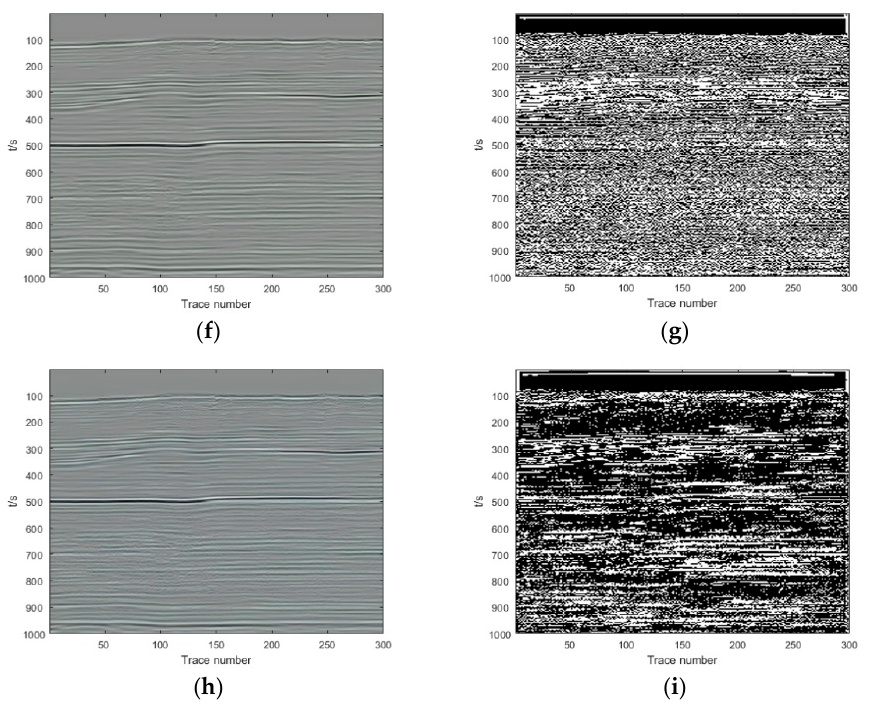
Figure 15. Denoising results of the sixth field example. ( a ) Noisy data; ( b ) Denoised image through the pre-trained model; ( c ) The difference profiles between noisy data ( a ) and pre-denoised data ( b ); ( d ) Denoised data through the proposed method; ( e ) The difference profiles between noisy data ( a ) and denoised data ( d ); ( f ) Denoised data through the DnCNN; ( g ) The difference profiles between noisy data ( a ) and denoised data ( f ); ( h ) Denoised data through the U-net; ( i ) The difference profiles between noisy data ( a ) and denoised data ( h ).